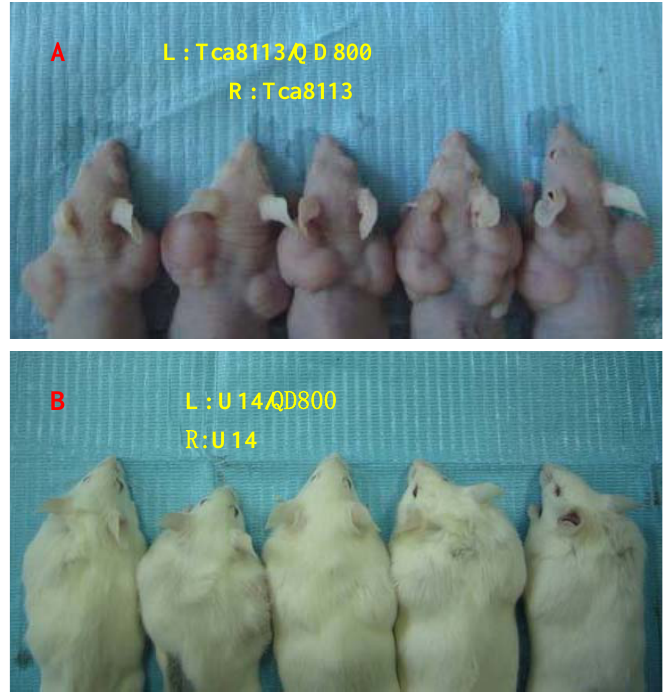
Figure 2. Tumorigenesis of QD800-labeled Tca8113 and U14 cells: ( A ) Tca8113/QD800 and Tca8113 cells ata concentration of 2  10 6 /mL were inoculated subcutaneously on the bilateral back of five nude mice and tumor growth was monitored 24 days later; ( B ) U14/QD800 and U14 cells at a concentration of 2  10 6 /mL cwere inoculated subcutaneously on the bilateral back of five Kunming mice and the tumor growth was monitored 14 days